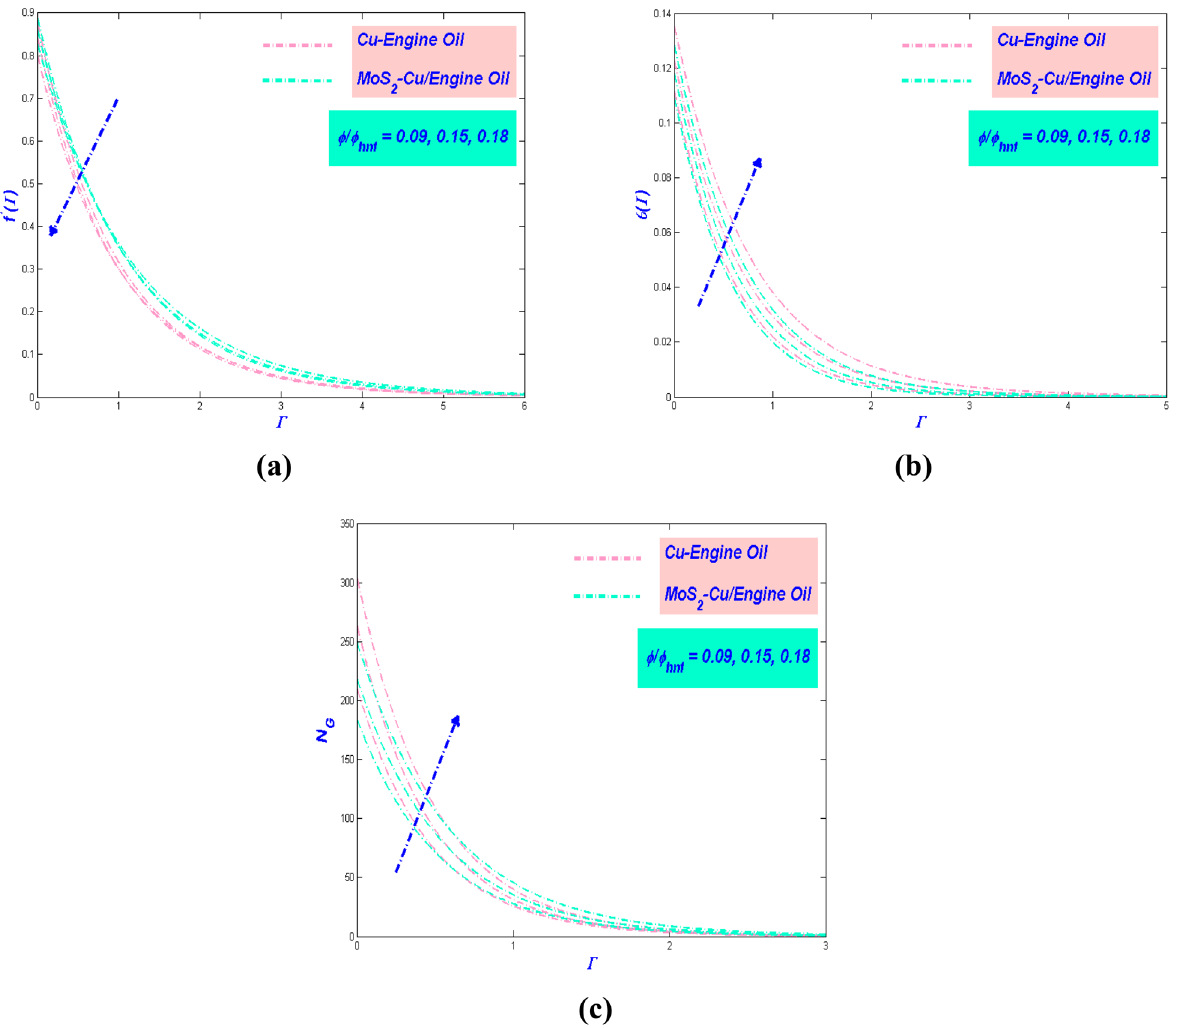
Figure 8. ( a ) Velocity, ( b ) temperature and ( c ) entropy versus φ and φ hnf